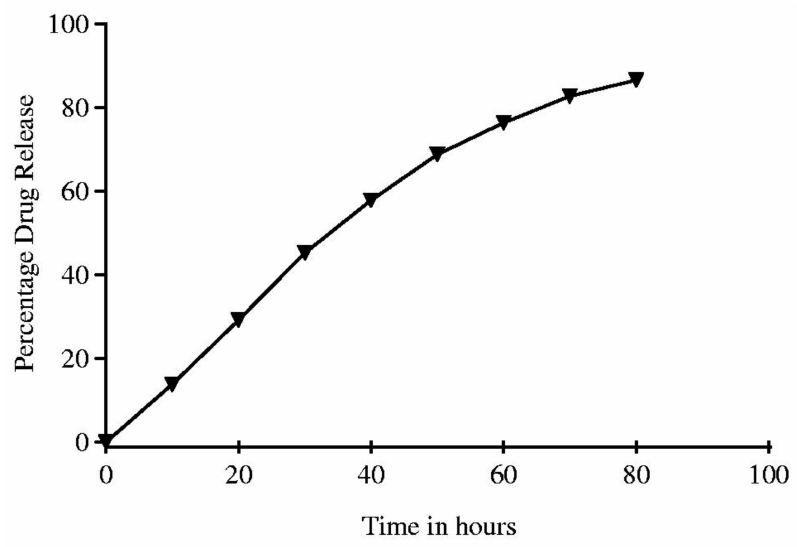
Figure 9. Profile of in vitro release of IMAB from IMAB-AgNPs, at 80 h of contact time in phosphate buffer (pH = 7.4), at 37 ◦ C. Reprinted from [40], with permission of the publisher Taylor & Francis Ltd., 2021.